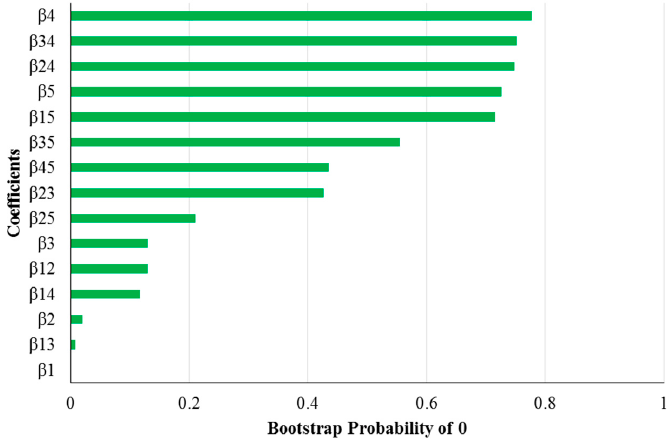
Figure 9. Ordering of (individual and interaction) effect sizes in terms of their bootstrap probability of zero for Manufacturer